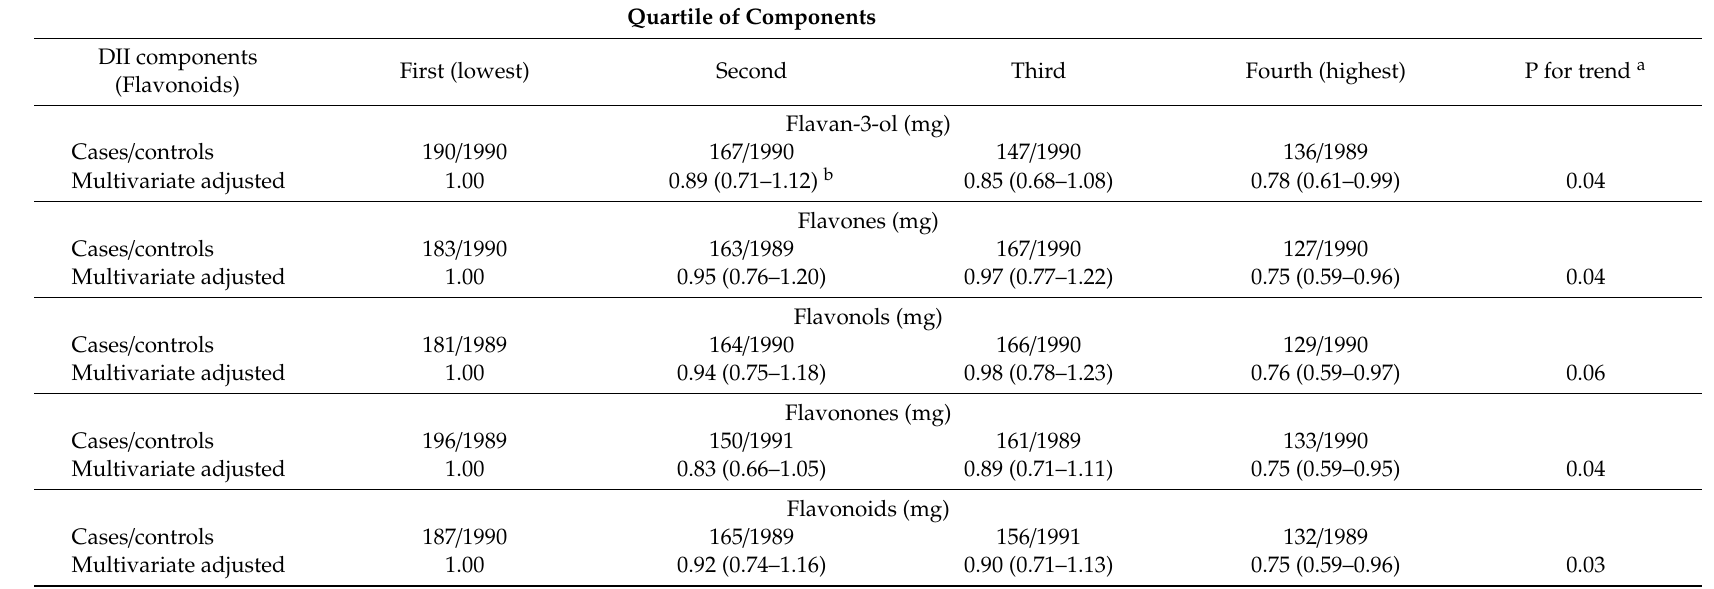
Table 4. Multivariable adjusted ORs of hyperuricemia and corresponding 95% CI by quartile of flavonoids of DII components in women in KoGES_CAVAS cohort. Quartile of